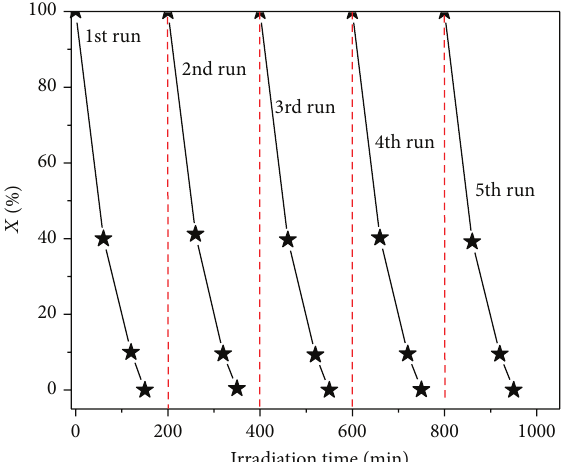
Figure 6: Cycling runs for the photocatalytic degradation of OII in the presence of CdS/CN-10 electrode under visible light irradiation.